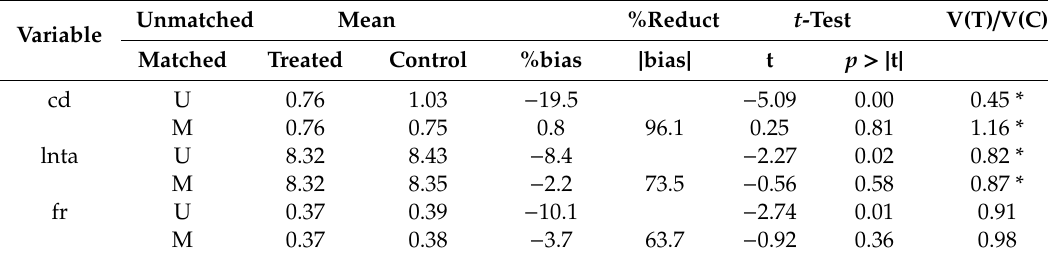
Figure A1. Deviation of covariates before and after matching. Table A1. Equilibrium test of covariates before and after